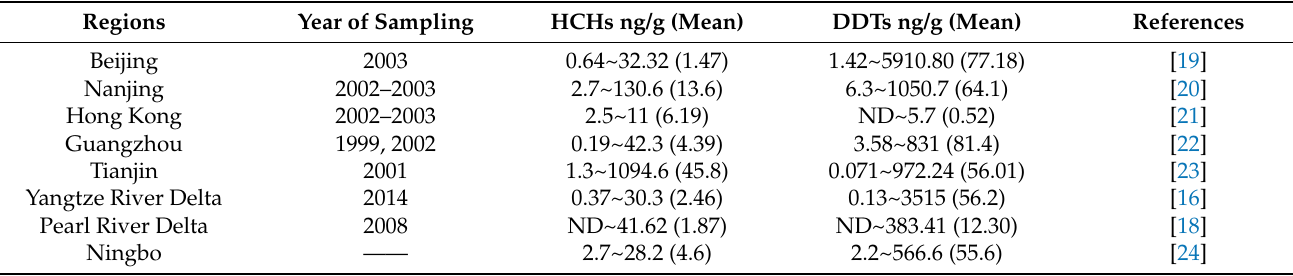
Table 2. Residual concentrations of HCHs and DDTs in soils of different